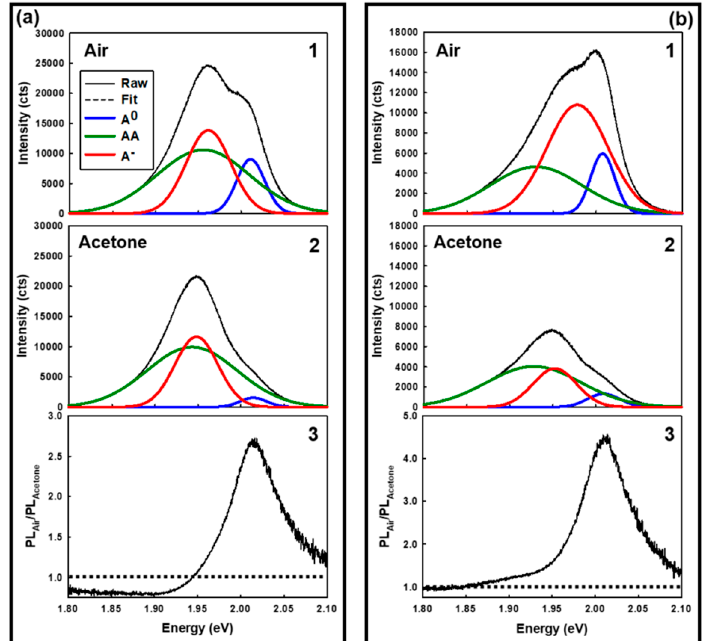
Figure 5. Typical single point PL emission spectra and curve fits from specific locations on the WS 2 flake shown in Figure 4. ( a ) Spectra from a single-layer WS 2 region. ( b ) Spectra from a few-layer WS 2 region. (1) Spectra recorded in air. (2) Spectra recorded under acetone vapor. (3) Energy-dependent PL Air / PL Acetone response spectra. The dashed line in spectra 3 located at 1.0 denotes no quenching. Spectral regions with PL Air / PL Acetone < 1 exhibit a PL enhancement under acetone vapor. Spectral regions with PL Air / PL Acetone > 1 exhibit a PL quench under acetone